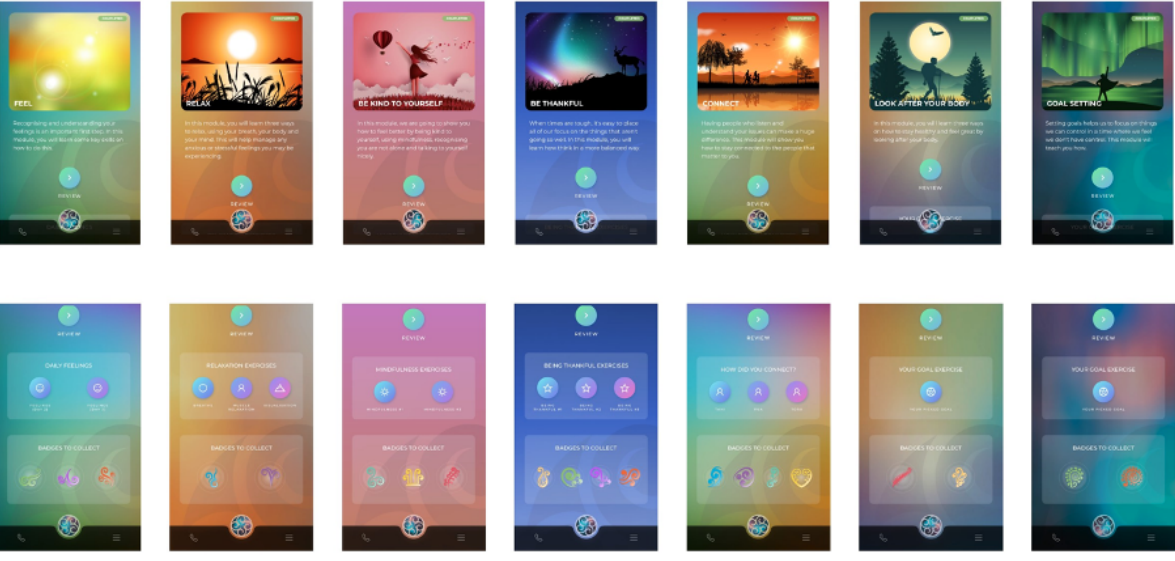
Figure 4. Screenshots of the seven modules and associated badges of the Whitu: 7 Ways in 7 Days